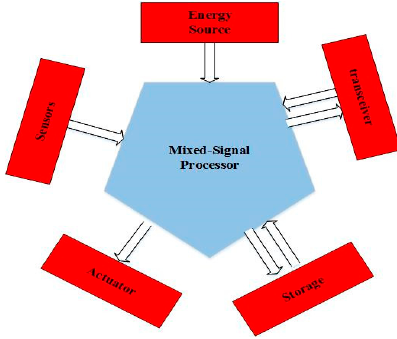
Figure 3. A body sensor node structure includes sensors, a mixed-signal processor, storage, a trans- ceiver unit, an energy source, and an actuator unit [5,23].